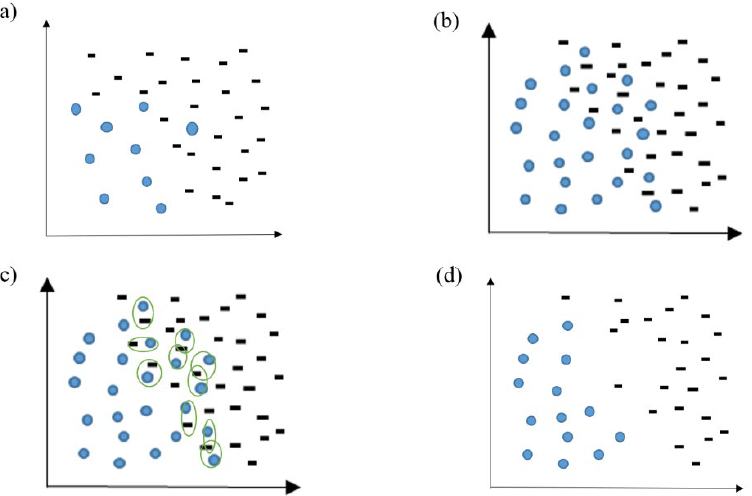
Figure 6. Raw dataset ( a ); dataset after SMOTE oversampling ( b ); Tomek-link recognition process ( c ); dataset after the boundary and noise samples are removed ( d ). Table 1. CRST Sampling Method.